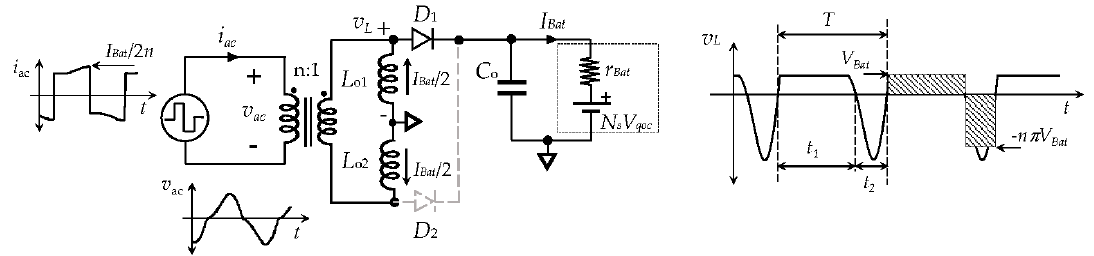
Figure 8. ( Left ) Current-doubler rectifier considering the positive semi-cycle of the drive voltage v ac . ( Right ) Theoretical voltage waveform at the filter inductors.